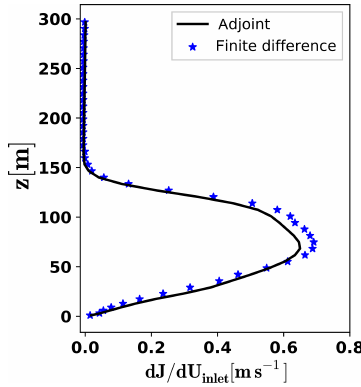
Figure 3. The 1-D inflow boundary (a) and the velocity profile and its selected target speeds in the domain (b) .